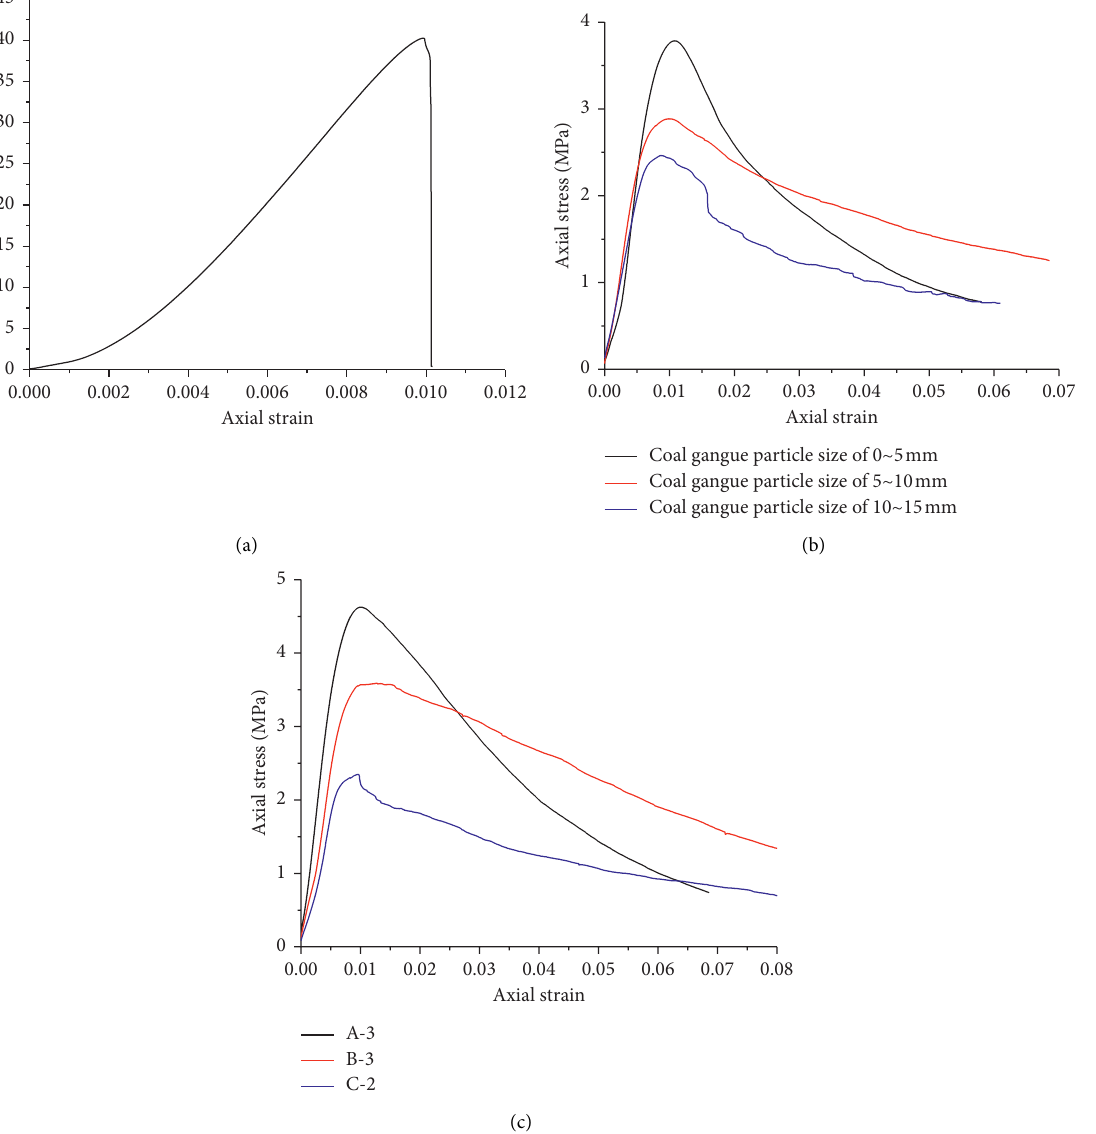
Figure 10: Stress-strain curves of (a) pure coarse sandstone sample, (b) pure CGFB samples, and (c) composite